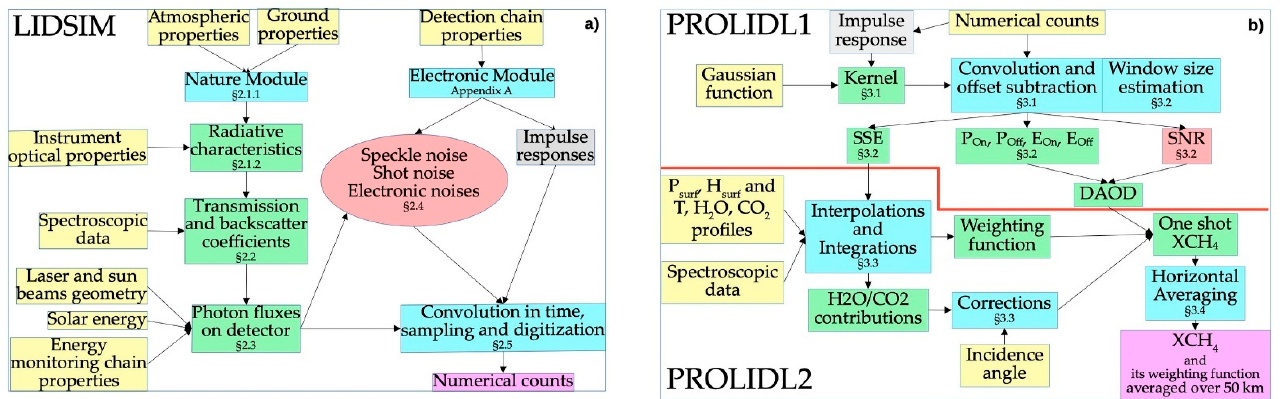
Figure 3. Flowcharts: ( a ) LIDSIM and ( b ) PROLID. In yellow the inputs, in blue the processes, in green some variables, in red those related to noise, in grey the impulse responses of the electronic chain, and in purple the outputs.